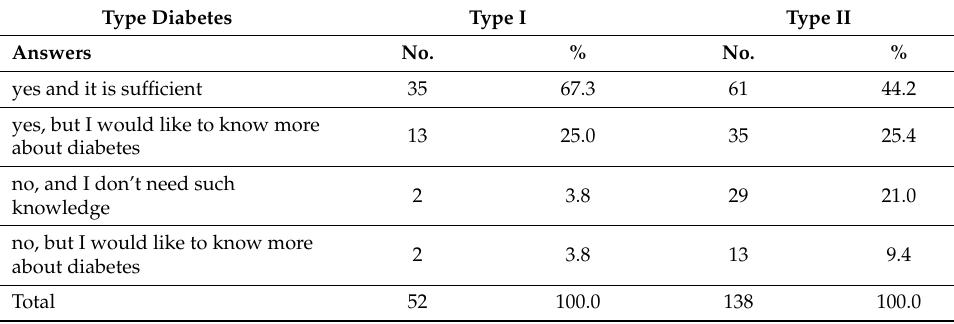
Table 3. Declaration of sufficient preparation for self-care in